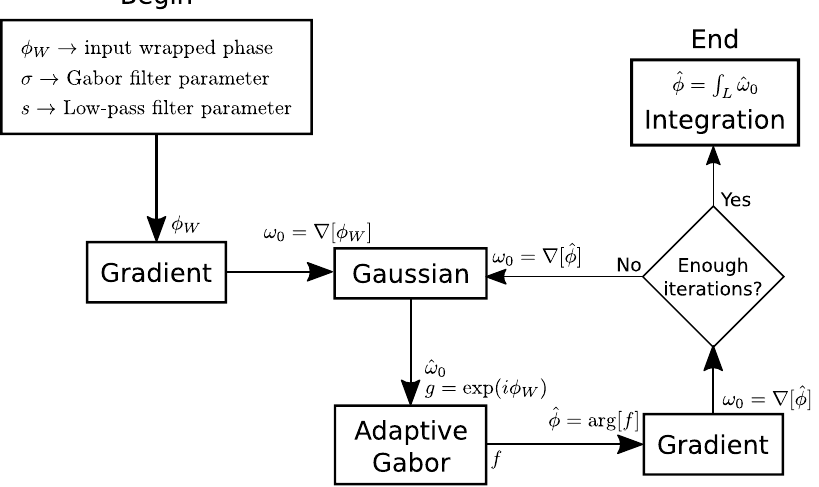
Figure 2. Block diagram of the method presented here. The gradient is taken by means of finite differences as in (4). Convergence takes about 6 iterations (see